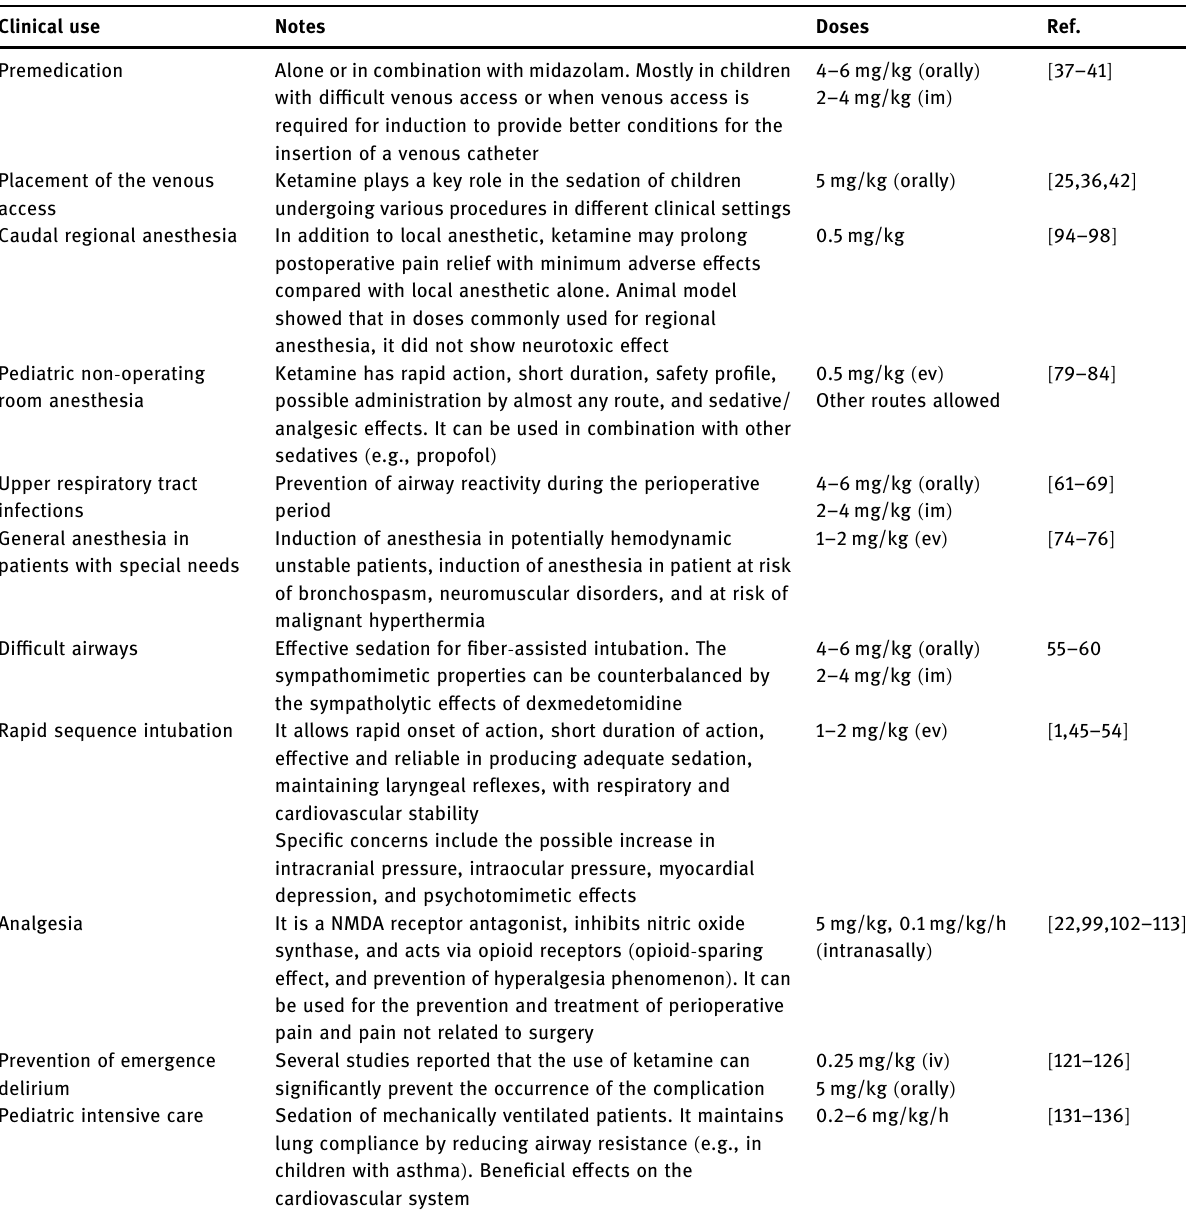
Table 2: Summary of the potential applications of ketamine in children care Clinical